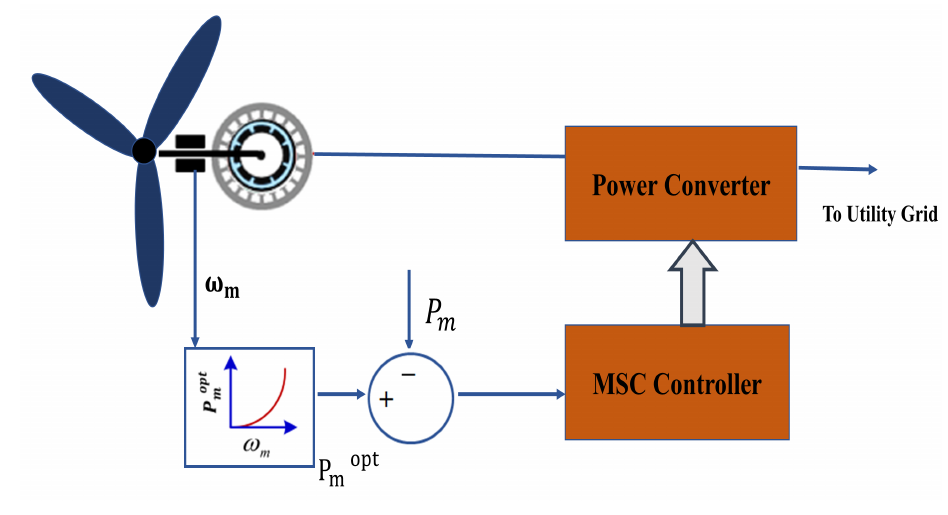
Figure 9. PSF MPPT algorithm. Table 1. Comparison of IPC based MPPT Algorithms for WECS. Reused with permission from Ref. [32,34,36,68]. Copyright 2012, 2015, 2016